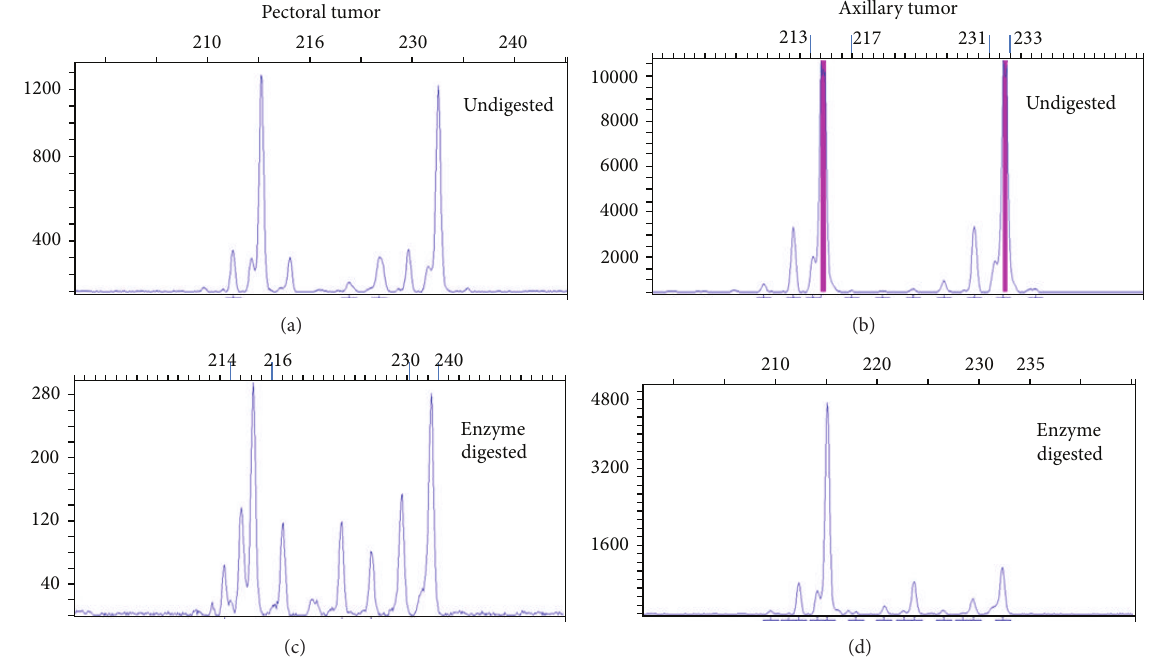
Figure 2: Fluorescent peak trace chromatogram of pectoral breast carcinoma and axillary metaplastic breast carcinoma. Pectoral invasive ductal carcinoma. (a, c) Polyclonal profile in the capillary electrophoresis characterized by the persistence of two distinct allele peaks after HpaII digestion. The additional smaller peaks are caused by slippage of the Taq polymerase. Axillary metaplastic breast carcinoma. (b, d) Complete disappearance of one allele peak after enzymatic digestion suggestive of monoclonal